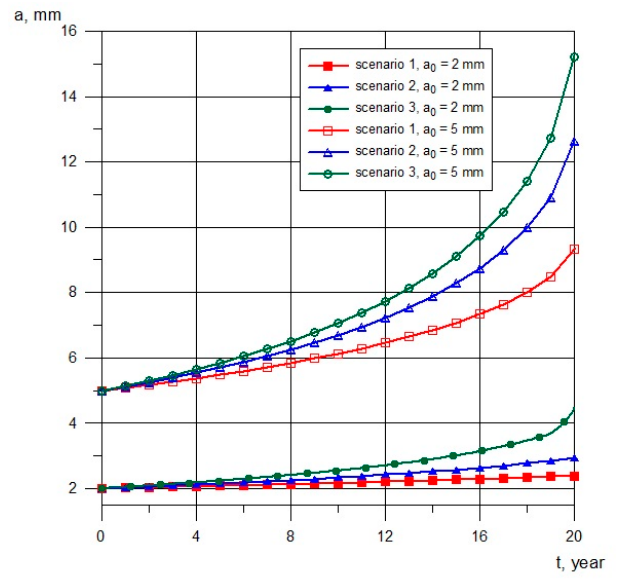
ff erent operating scenarios ( a